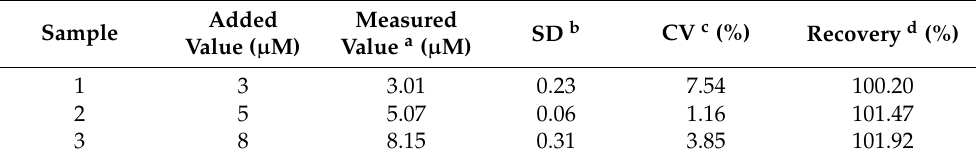
Table 2. Detection precision of the His@MNPs based assay for the determination of ACh levels in spiked human serum sample.